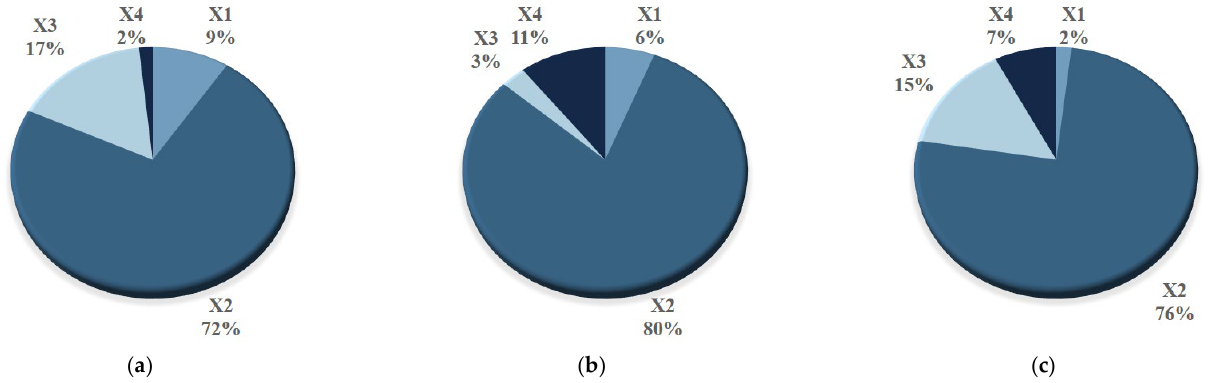
Figure 10. Analysis of variance (ANOVA) results for the constructed kriging model; ( a ) drag coefficient; ( b ) internal volume; ( c ) lift coefficient. cient; ( b ) internal volume; ( c ) lift